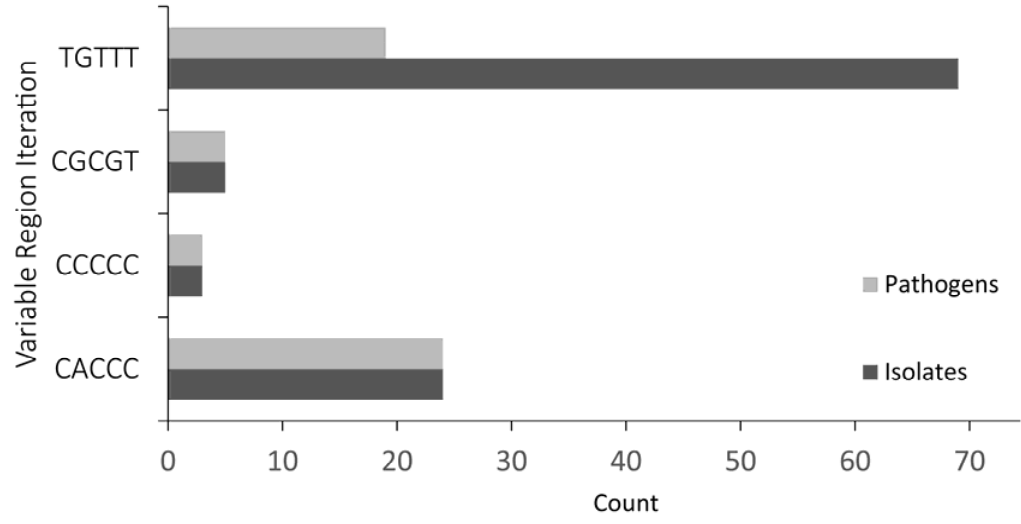
Figure 4. Bacterial isolates that encode for a RyfA1-like molecule are enteropathogens. All bacterial isolates whose genome is sequenced and available on the National Center for Biotechnology Information (NCBI) [21], were evaluated for the presence of ryfA . Next all identified species were grouped based on the similarity of nucleic acid sequence within the ryfA five-nucleotide variable region. Four different iterations of the variable region were found, TGTTT, CGCGT, CCCCC, and CACCC. Three of the four variable region iterations contained higher GC content and were termed “ ryfA1 -like”. The number of isolates containing each RyfA iteration as well as the number of those with each group that are pathogenic are indicated.